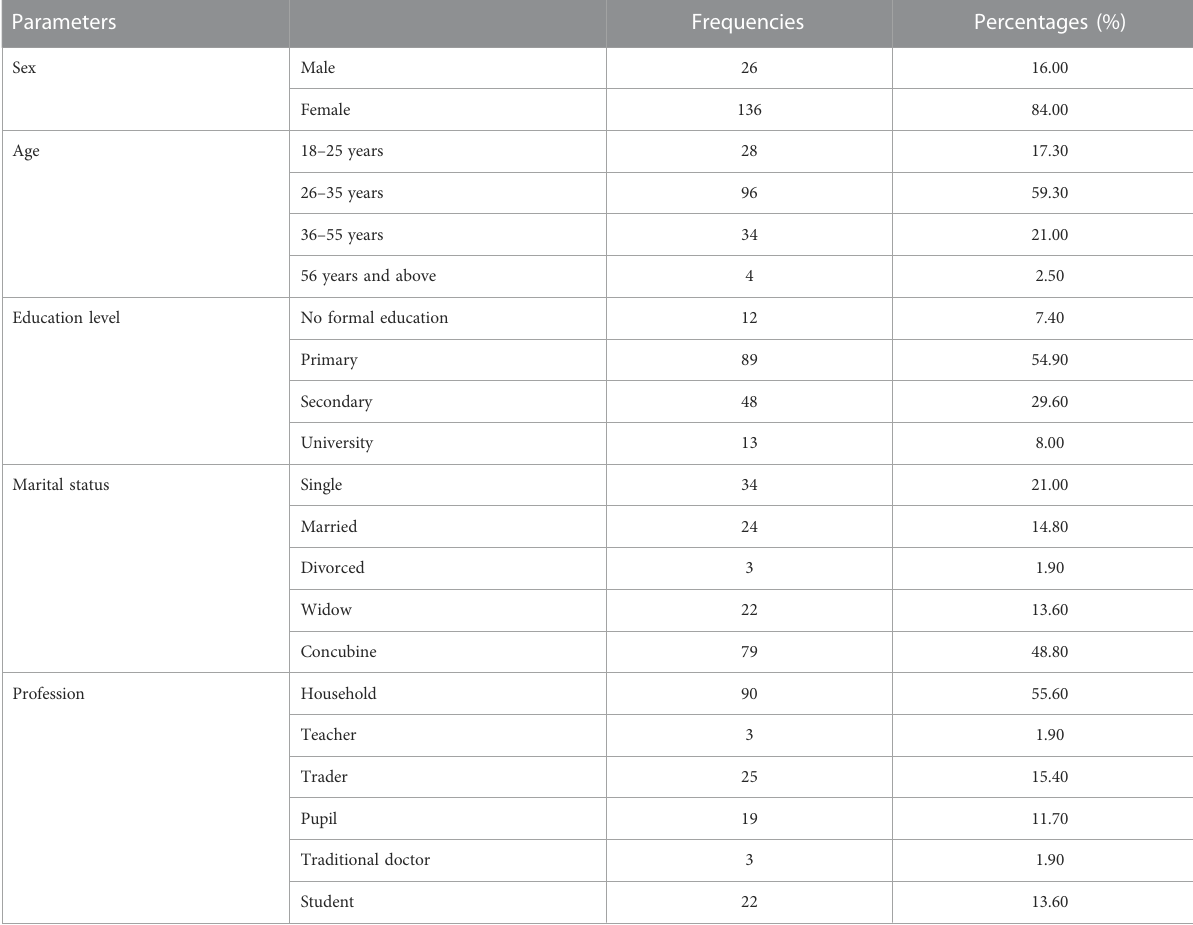
TABLE 1 Socio-demographic characteristics of the study population.